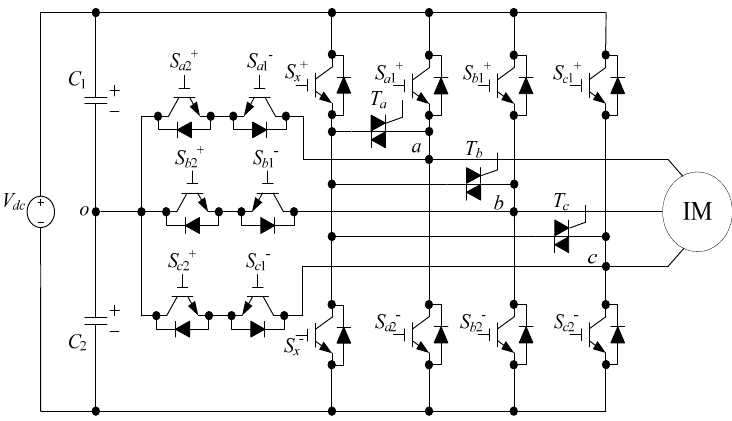
Figure 9. The architecture of proposed three-level T-type inverter.